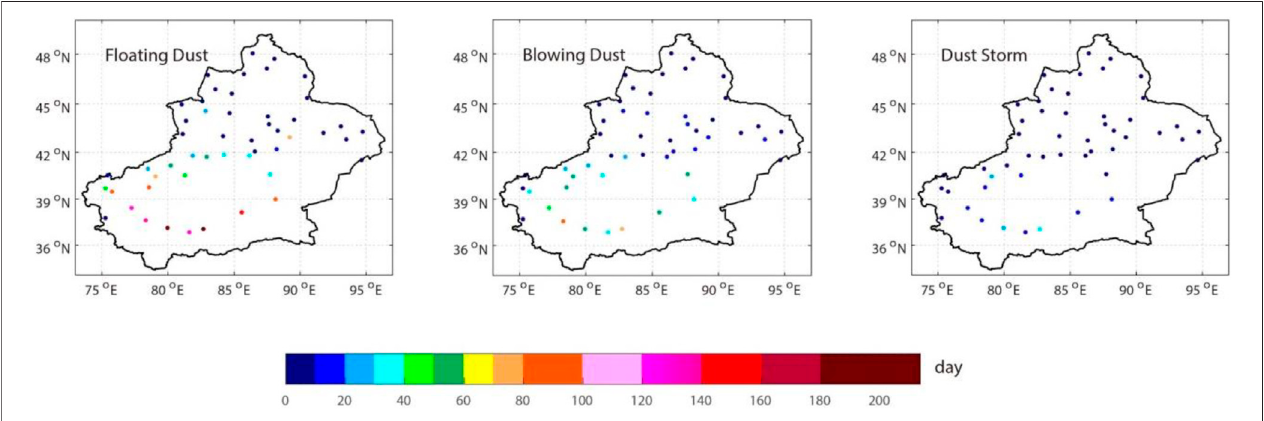
FIGURE 3 | Spatial distribution of fl oating dust, blowing dust and dust storm in